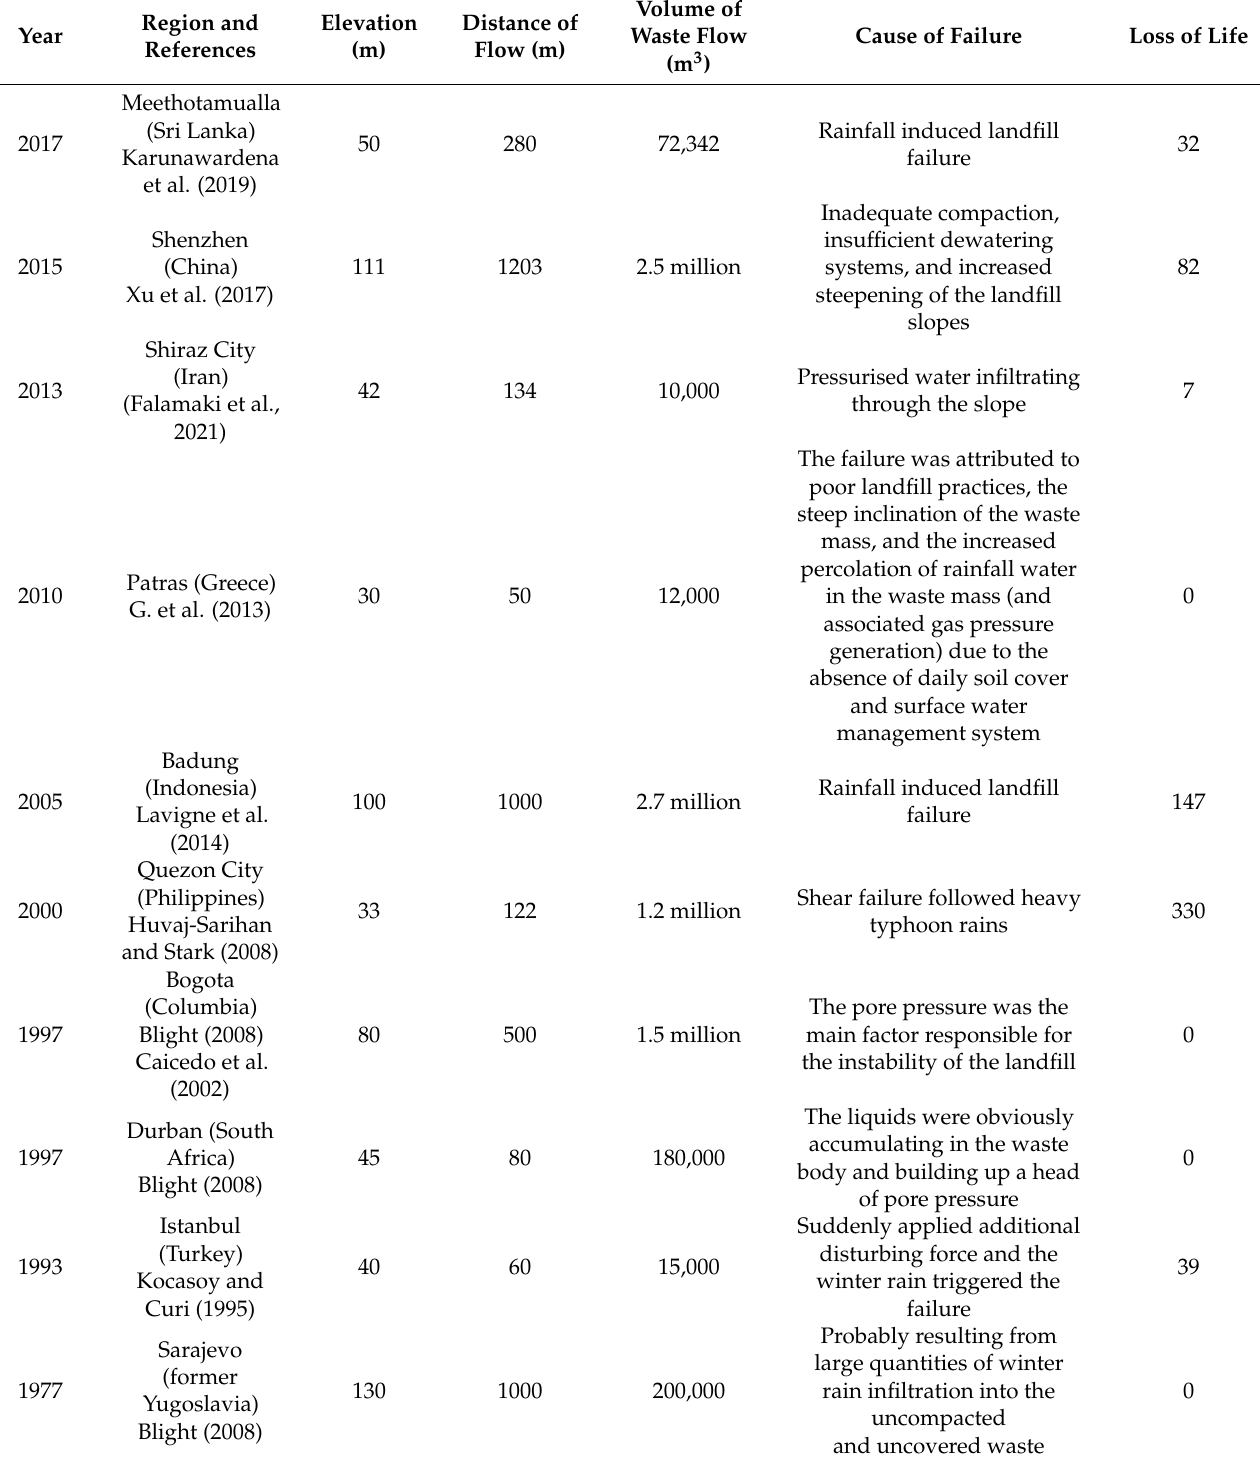
Table 1. Review of MSW landfill failures worldwide over the past